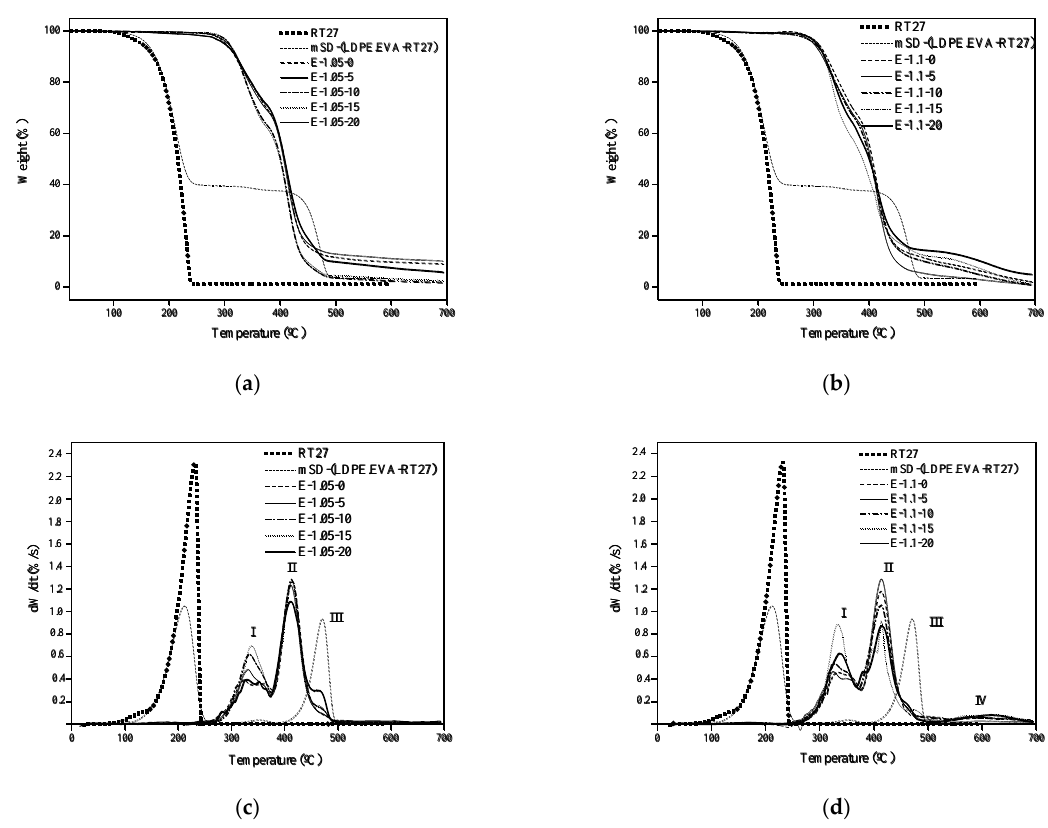
Figure 6. Thermogravimetric analyses ( a , b ) and their DTGs ( c , d ) of the synthesized elastomers, mSD-(LDPE·EVA-RT27) and the pure paraffin. Peaks I = HS degradation; Peak II = SS degradation; Peak III = high molecular weight reticulated segment degradation; Peak VI = allophanates degradation.